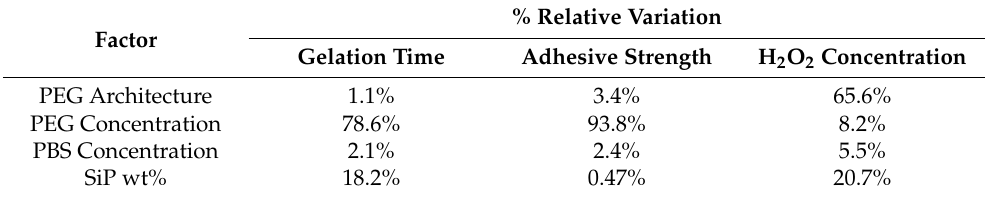
Table 3. Percent relative variation of each factor on the performance of the